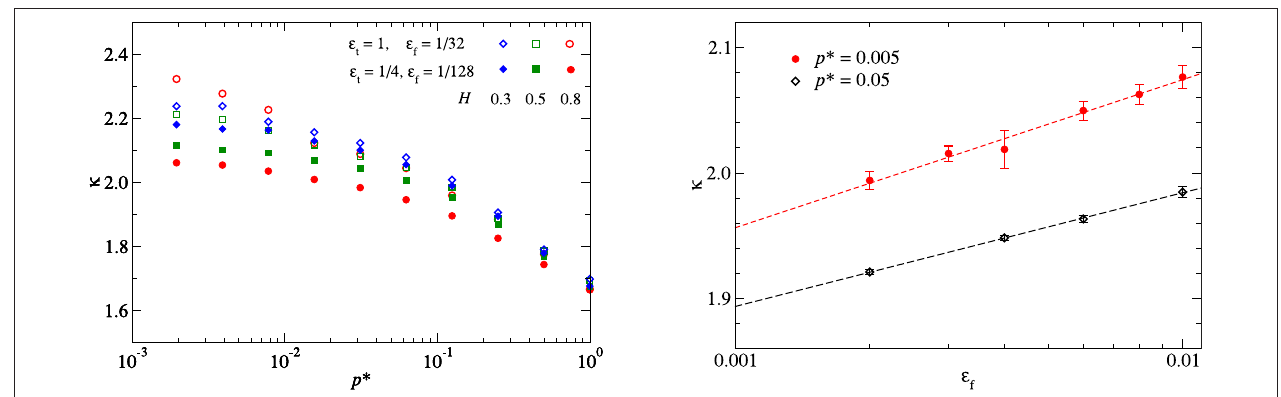
FIGURE 5 | (Left) Proportionality coefficient κ as function of reduced pressure p ∗ for three Hurst parameters and two fixed ratios of ε t,f , namely (i) ε t ε f 1 / 32 and (ii) ε t 1 / 4 and ε f 1 / 128. (Right) Scaling with ε f for H = = = averaged over up to 100 random realizations per data